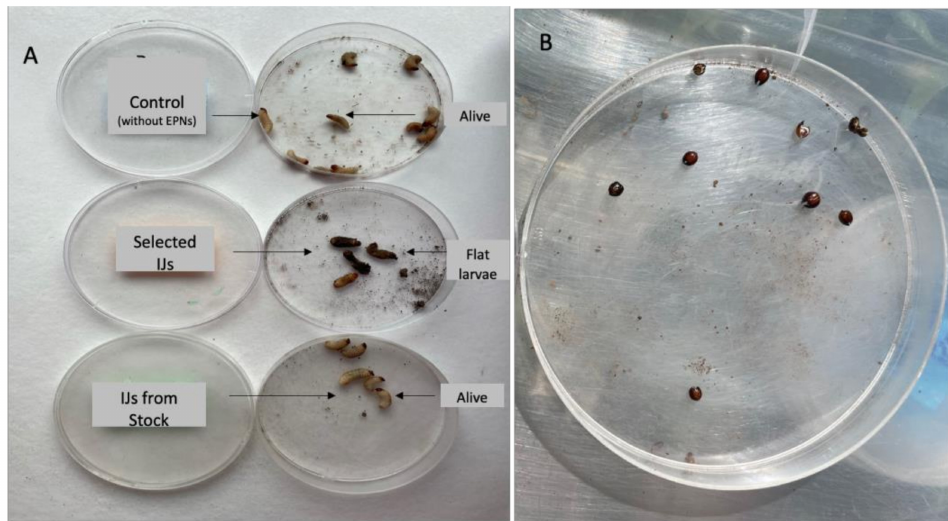
Figure 7. A . superciliosus larvae cadavers. ( A ) Larvae treated without EPN, with the selected IJs and IJs from the stock and ( B ) cephalic capsules obtained after 96 h of treatment of the larvae with the selected